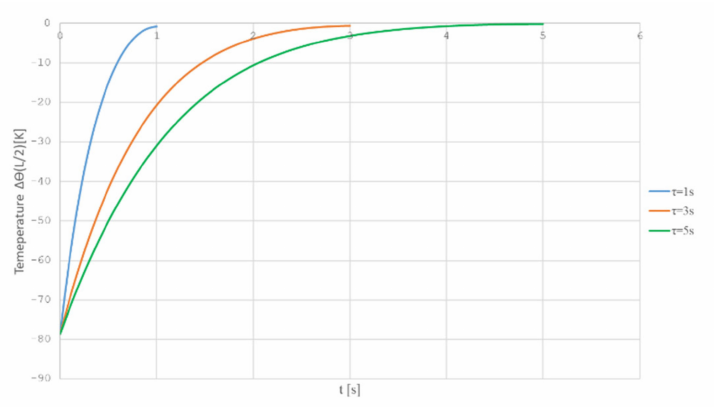
Figure 6. Temperature dependence ∆Θ ( t , z ) from time to time in various time modes control τ ; z coordinate is fixed by z = L /2